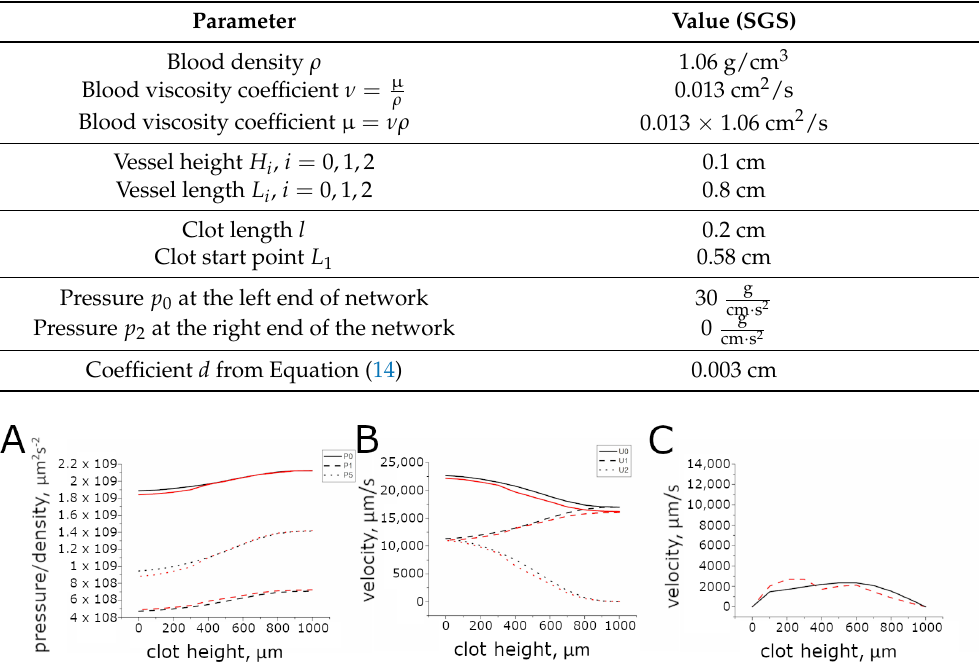
Figure 5. Comparison of analytical (black lines) and numerical (red lines) results. ( A ) The pressure at the inlet ( P 0 ) of the network, in the middle of the branching vessel without the clot ( P 1 ) and in the bifurcation point ( P 5 ) as functions of clot height. ( B ) The flow velocity in the middle of vessel 0 ( U 0 ), vessel 1 ( U 1 ) and vessel 2 ( U 2 ). ( C ) The maximal velocity above the